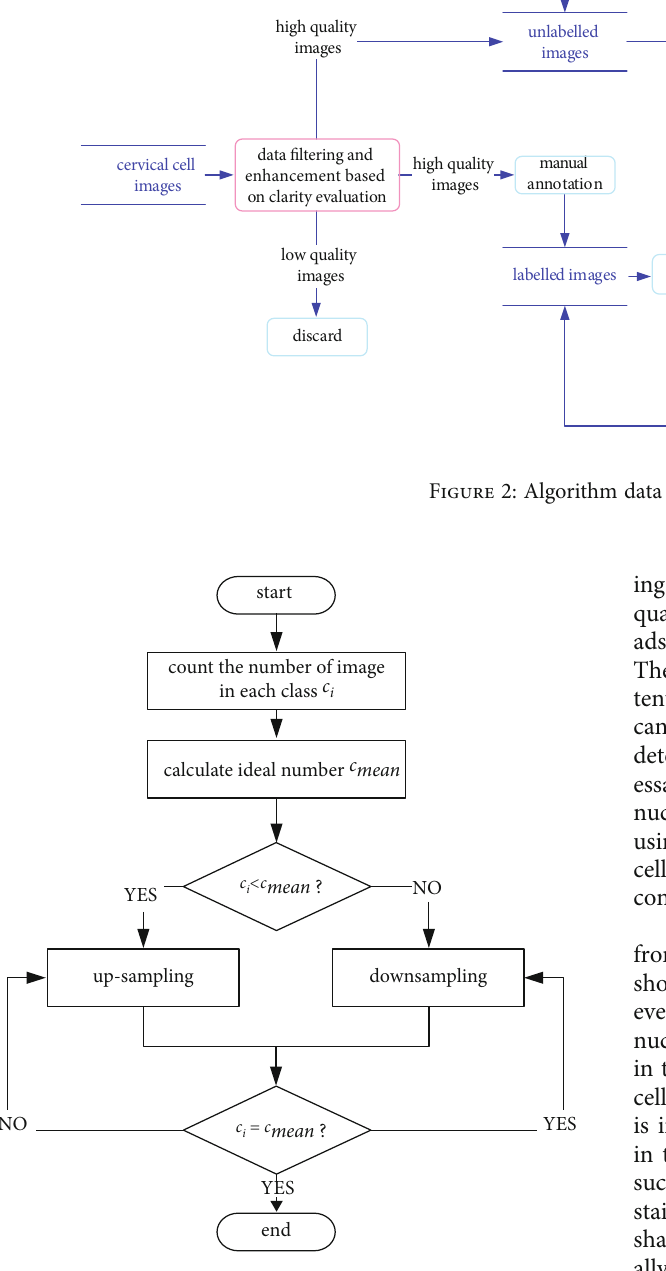
Figure 3: Data balancing fl owchart.